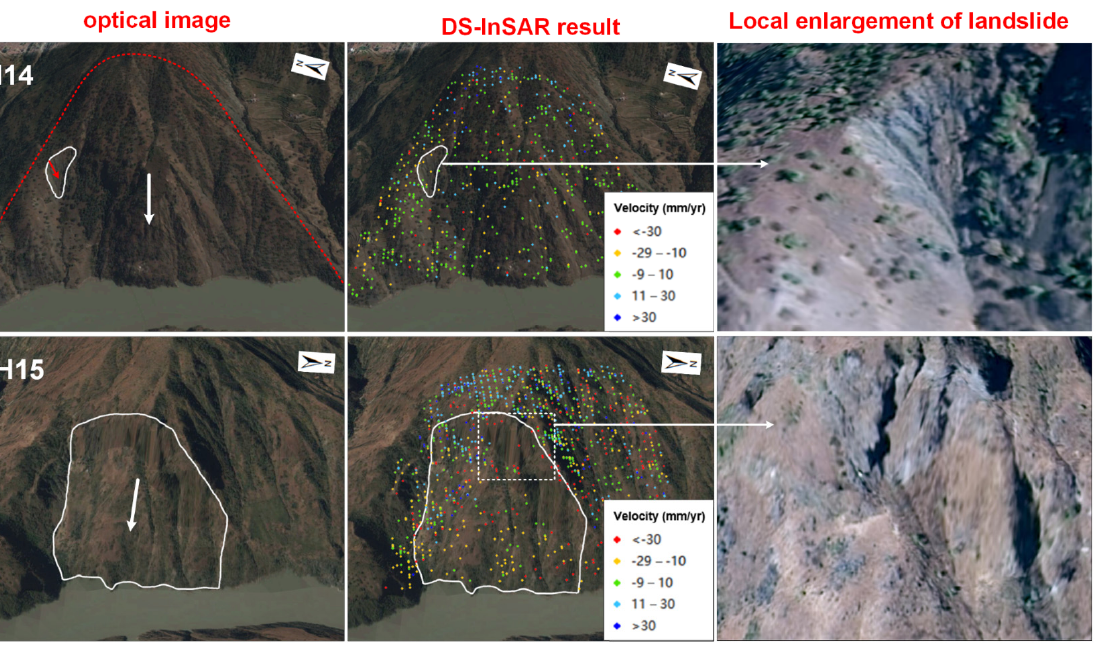
Figure 9. Landslide definition based on optical image recognition and DS-InSAR results.